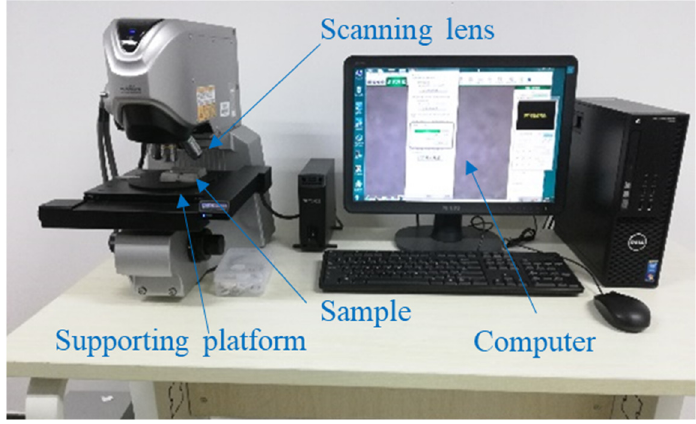
Figure 4. The laser microscope for testing the roughness of fracture surface.